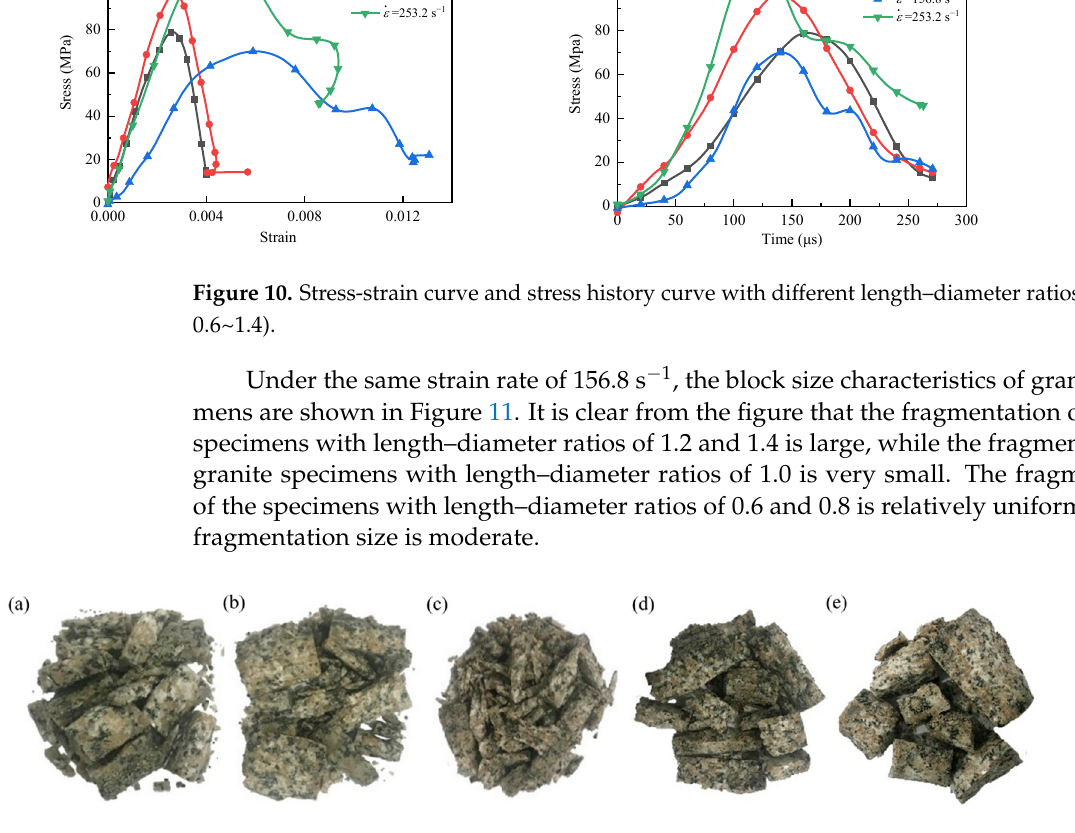
Figure 11. Impact fracture morphology of granite samples under 156.8 s − 1 stain rate (( a – e ) for different length–diameter ratios, 0.6 to 1.4).